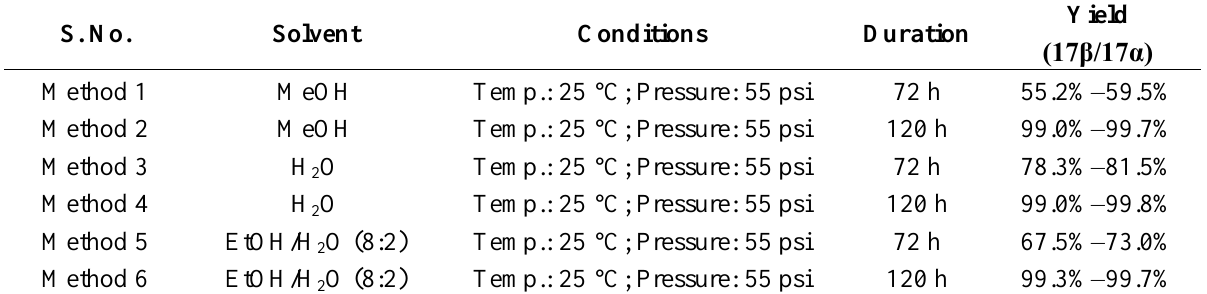
and yields of various methods. 2